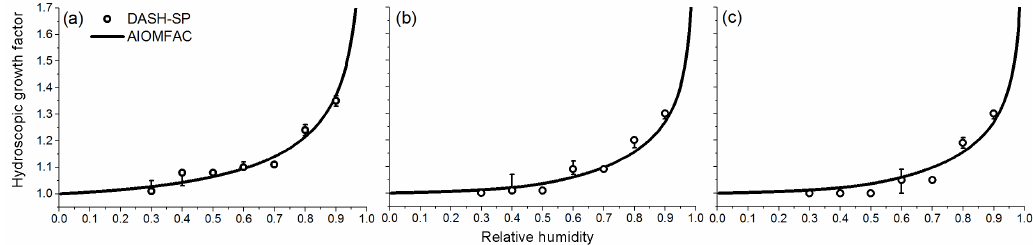
Figure 4. Comparison of hygroscopic growth factors measured with the DASH-SP and those predicted by AIOMFAC for (a) PEG200, (b) PEG1000, and (c) PEG10000 for particles with diameters of 250nm. For the DASH-SP measurements, symbols indicate the average HGF and error bars indicate the maximum and minimum HGFs derived from repeat